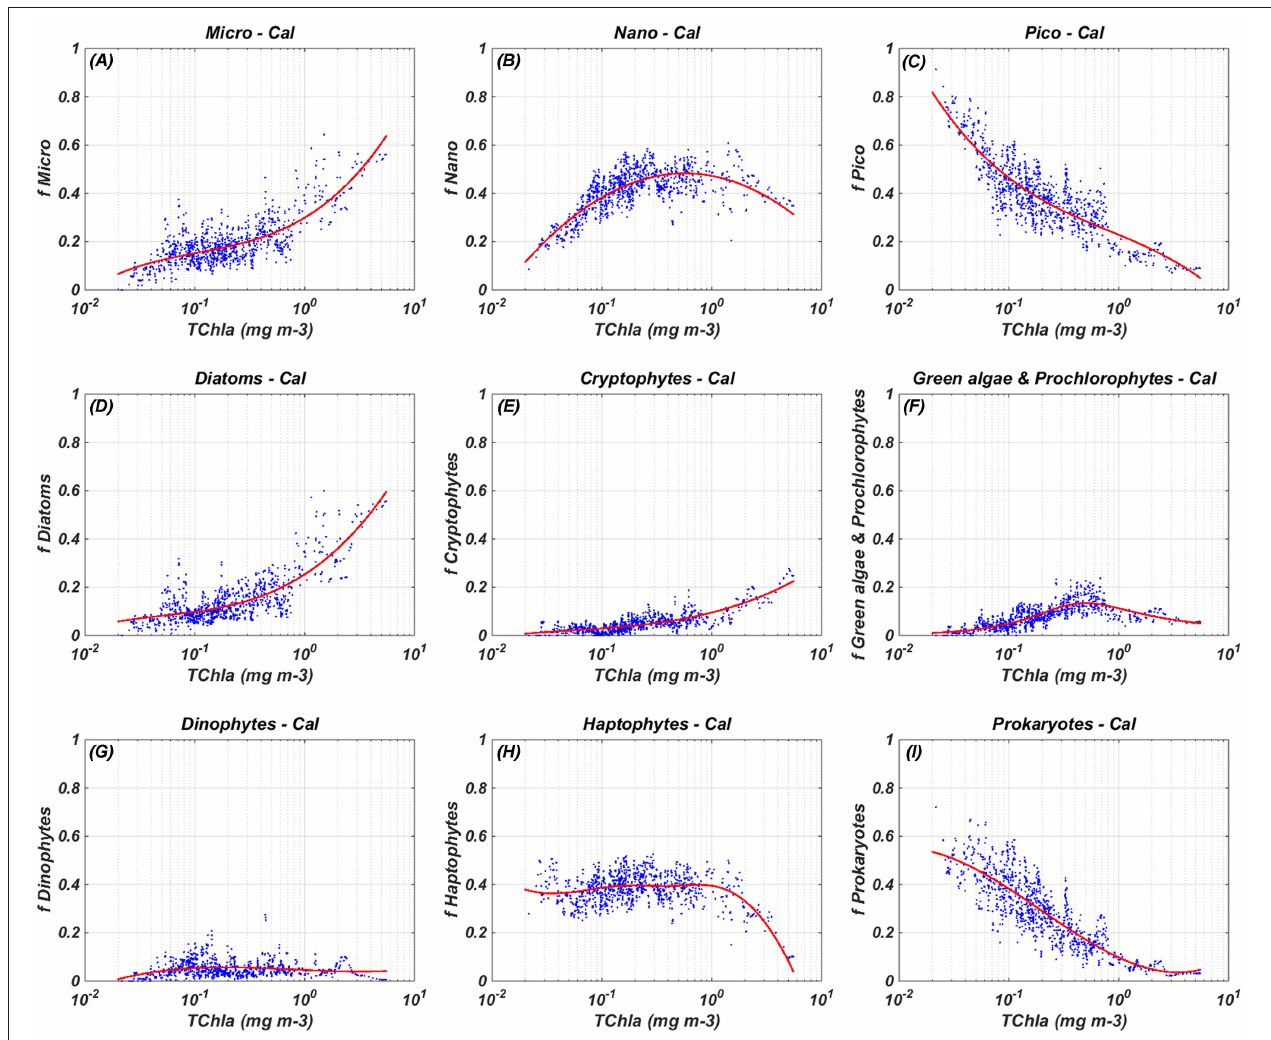
FIGURE 2 | Regional relationships between in-situ TChl a and the fraction (f) of each PSC and PFT: calibration (Cal) results. The blue dots refer to the in-situ PSC/PFT fraction obtained from equations in Table 3 (966 data) and the red line indicates the best fitting curve obtained from the calibration (see equations in Table 4 ). (A) Micro-Cal, (B) Nano-Cal, (C) Pico-Cal, (D) Diatoms-Cal, (E) Cryptophytes-Cal, (F) Green algae & Prochlorophytes-Cal, (G) Dinophytes-Cal, (H) Haptophytes-Cal, and (I)